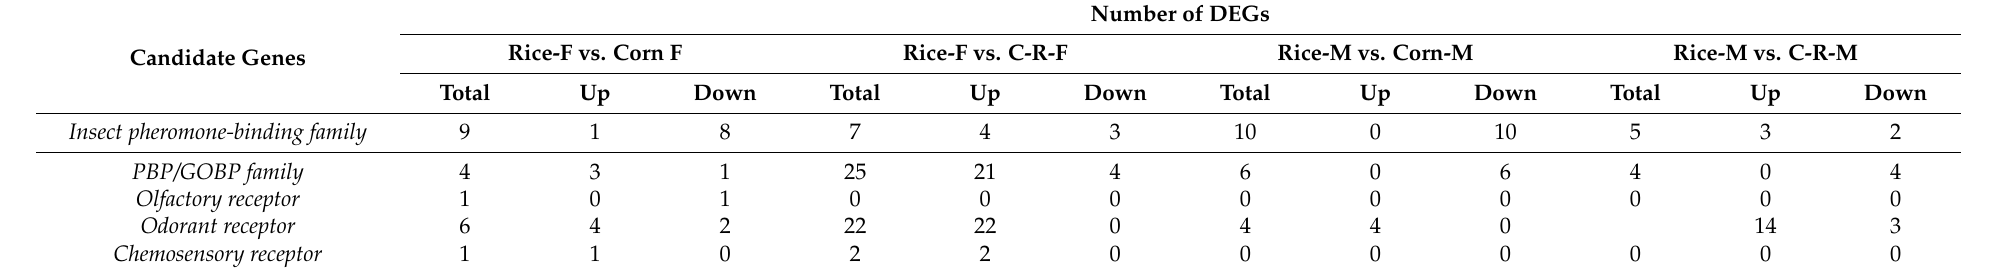
Table 3. Summary of candidate differentially expressed genes related to chemosensation in male and female antennal transcriptome of Spodoptera frugiperda, Rice-female vs. Corn-female, Corn-female vs. C-R-female (After 20 generation the corn population was fed on rice for one generation (C-R-female)) and Rice-male vs. Corn-male, Corn-male vs. C-R-male antennae after feeding on Corn and rice plants for 20 generations or on rice for one generation